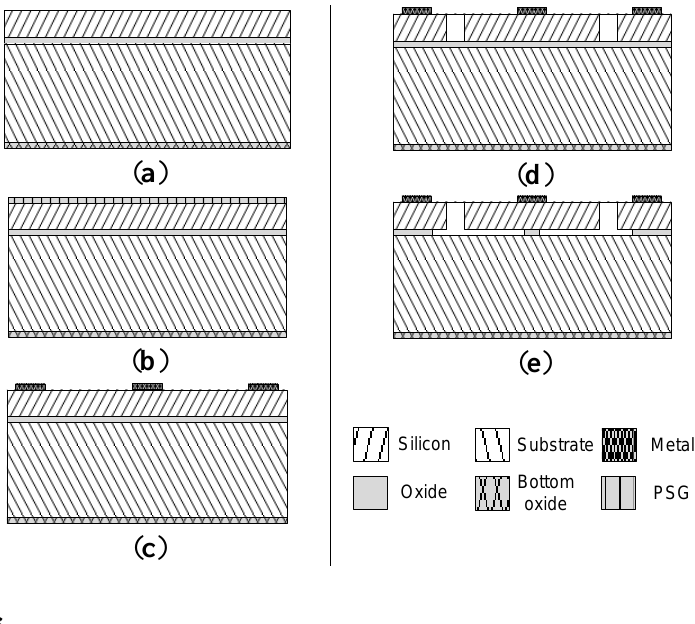
Figure 7. Simplified processing steps of the SOIMUMPs technology